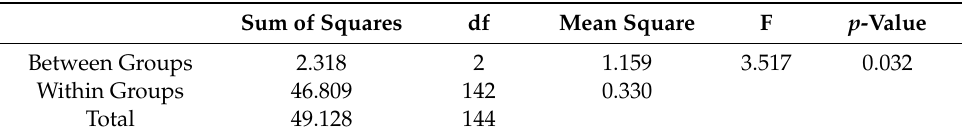
Table 9. ANOVA perceived thermal comfort (PTC) analyses in the three investigated selected points. Sum of Squares df Mean Square Between Groups 2.318